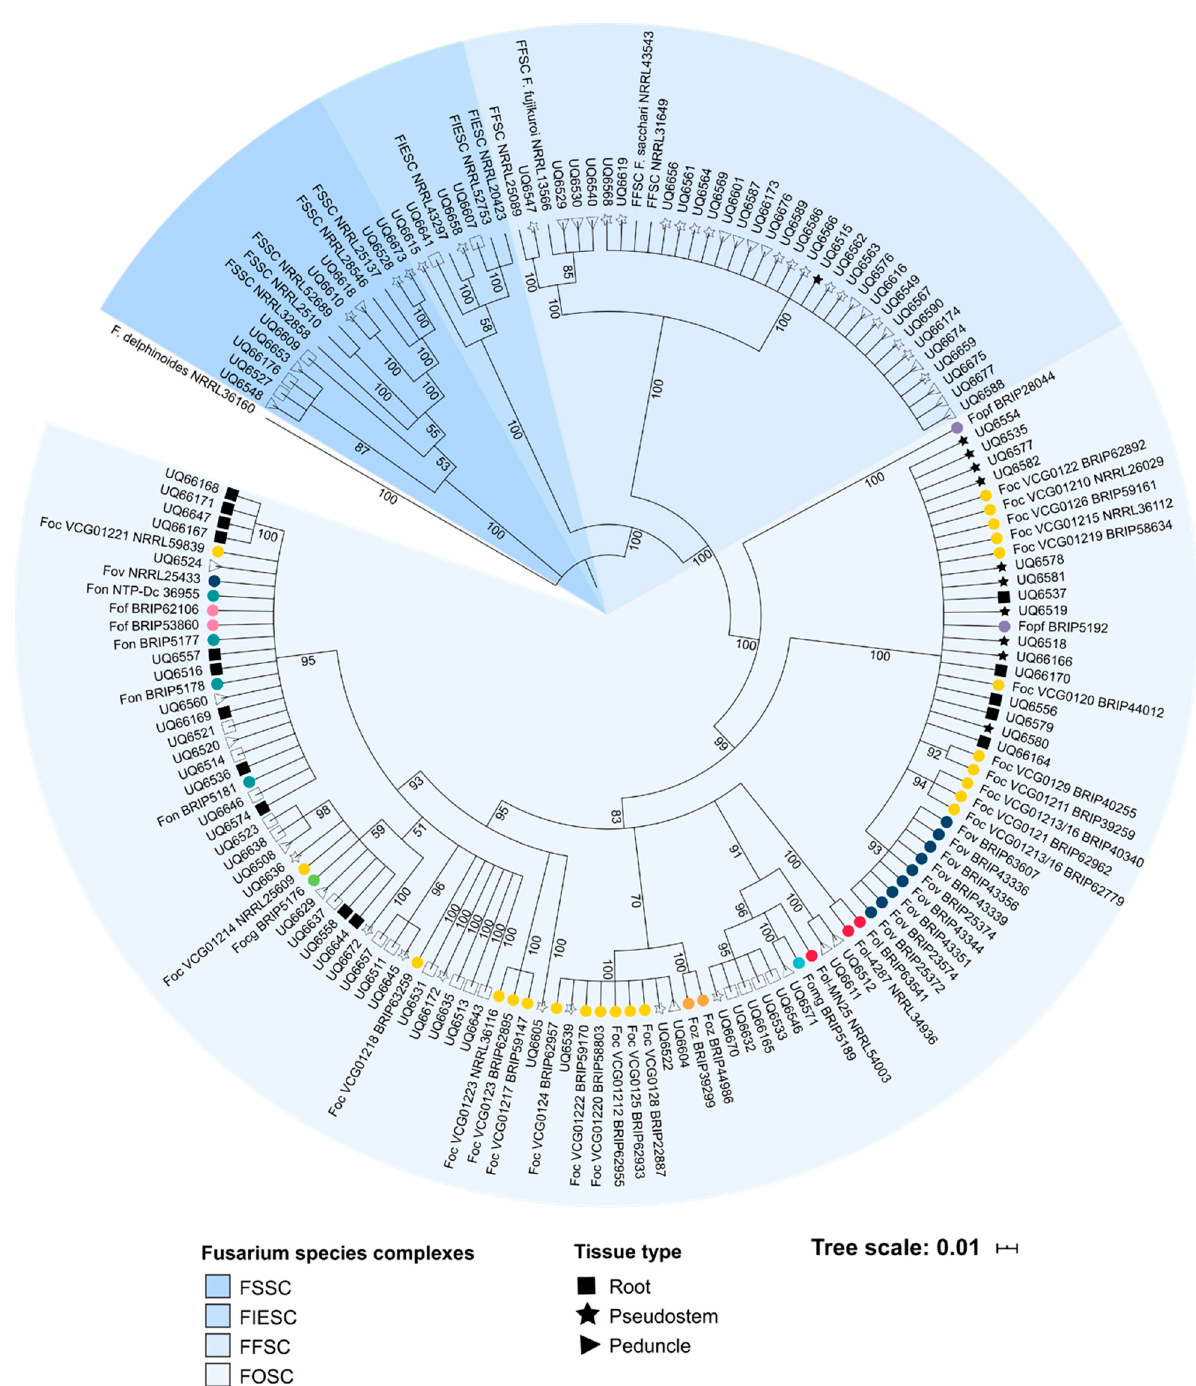
Figure 1. Phylogenetic tree of Fusarium isolates recovered in this study, reference sequences from pathogenic formae speciales of Fusarium oxysporum and other isolates from several Fusarium species complexes (FIESC— Fusarium incarnatum-equiseti species complex; FFSC— Fusarium fujikuroi species complex; FOSC— Fusarium oxysporum species complex; FSSC— Fusarium solani species complex). Pathogenic formae speciales of F. oxysporum are indicated with a coloured circle. The tissue from, which the isolates were recovered, is indicated by either a square (root), star (pseudostem) or triangle (peduncle). Isolates recovered from the Redlands site have a shaded shape. Isolates recovered from the Mullumbimby site have an unshaded shape. Nucleotide sequences from the translation elongation factor 1- α ( EF1- α ) locus were aligned and analysed using Bayesian inference. Branch labels indicate posterior probability determined during the analysis.